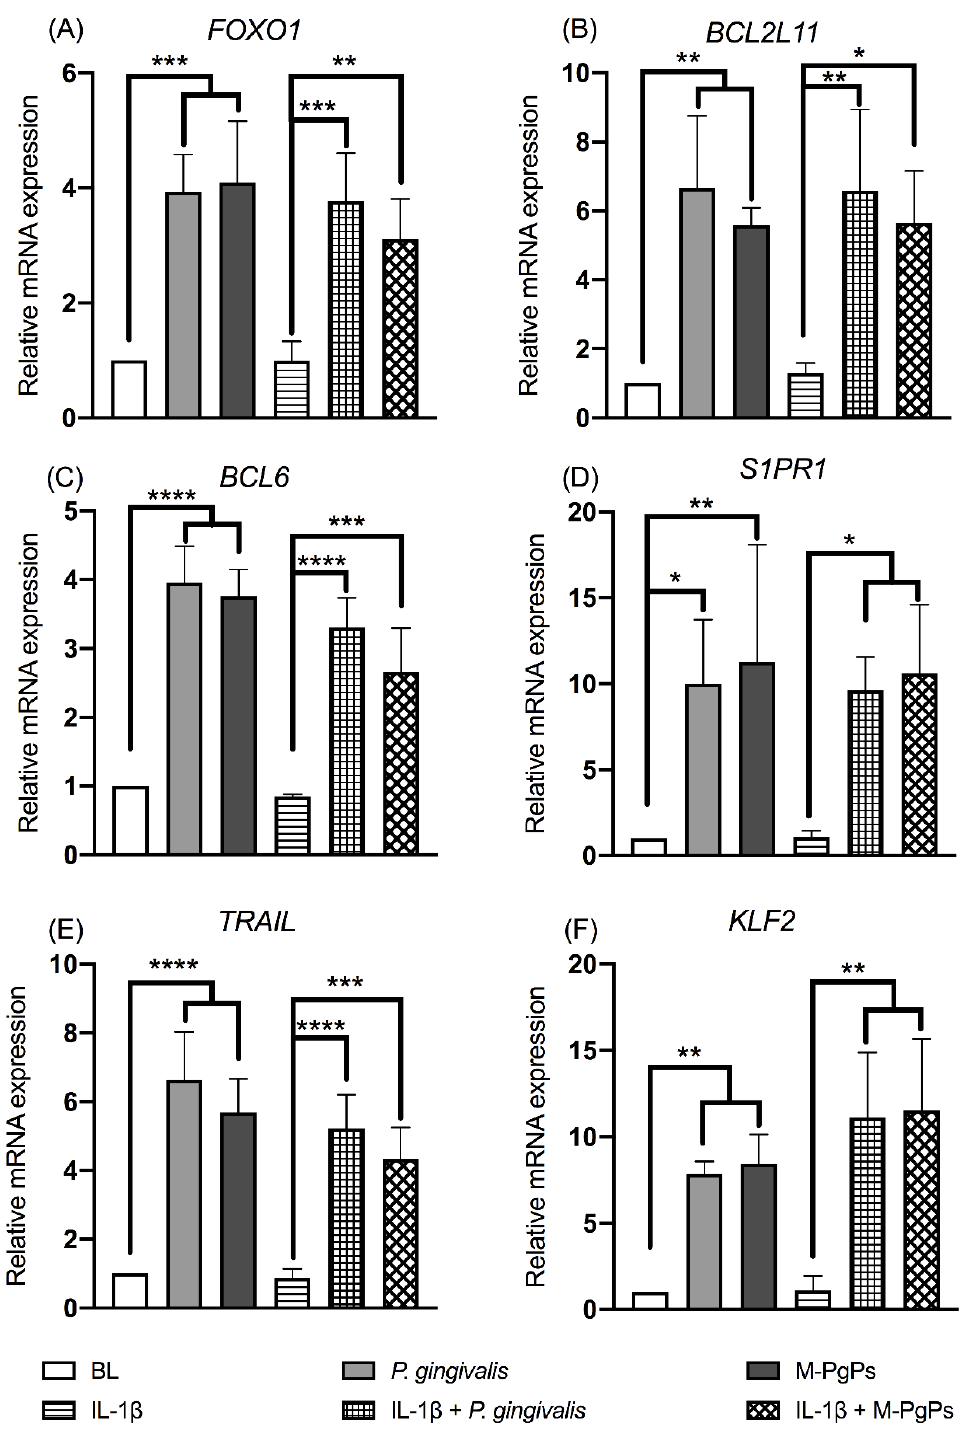
Figure 4. FOXO signaling pathway in HGECs was upregulated by M-PgPs. Relative mRNA expres- sion levels of FOXO1 ( A ), BCL2L11 ( B ), BCL6 ( C ), S1PR1 ( D ), TRAIL ( E ) and KLF2 ( F ) in HGECs after the treatment of M-PgPs (1:100) for 24 h were analyzed using RT-qPCR. HGECs without any treatment served as blank control (BL). HGECs treated with P. gingivalis (1:100, 24 h) served as positive control. IL-1 β (1 ng mL − 1 ) was added 6 h before M-PgPs and P. gingivalis treatment. * p < 0.05; ** p < 0.01; *** p < 0.001; **** p < 0.0001. Data represent the mean ± SD of three independent experiments.